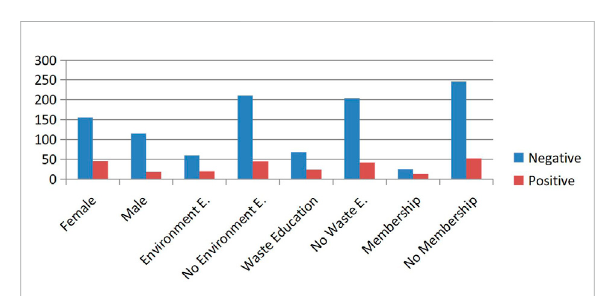
FIGURE 3 Module two additive sums of positive and negative answers.